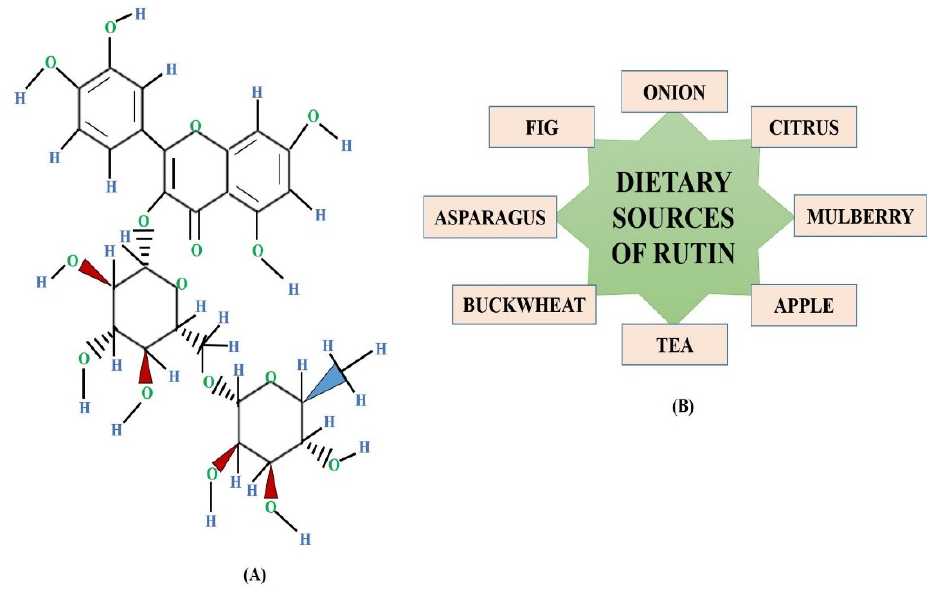
Figure 1. Structure and dietary sources of rutin (bioflavonoid): ( A ) structure and ( B ) dietary